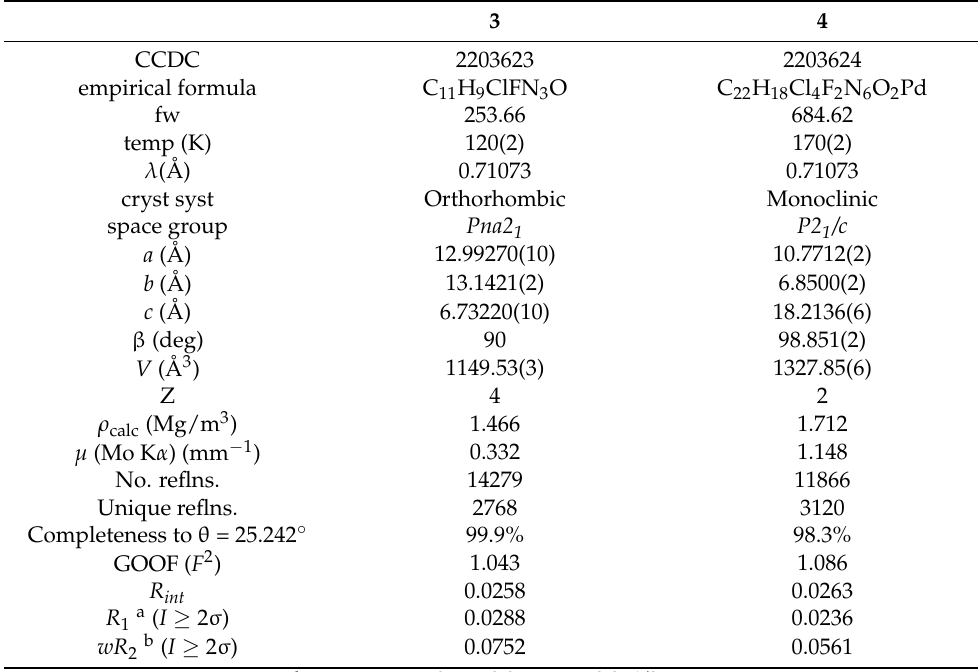
Figure 2. X-ray structure of triazole ligand 3 . List of some bond important distances and angles is given in Table 2. Table 1. Crystal data for triazole ligand 3 and Pd(II)-complex 4 .